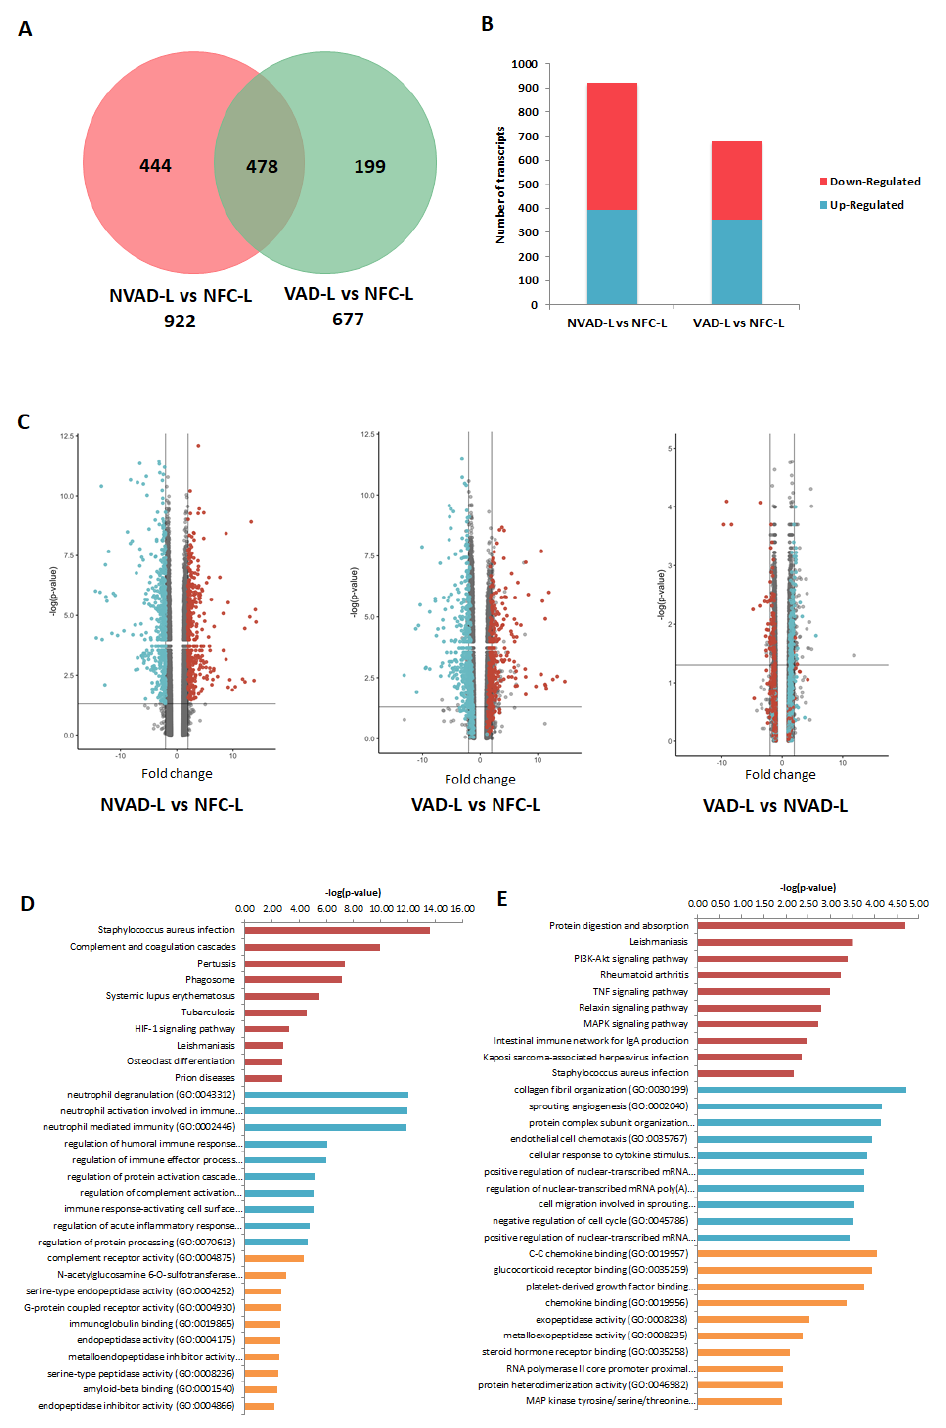
Figure 3. mRNA analysis of left ventricles (LV) from dilated cardiomyopathy (DCM) hearts with (VAD) and without left ventricle assist device (NVAD), using the non-failing controls (NFC) as reference. ( A ) Number of significant differentially expressed transcripts in the VAD and NVAD groups. ( B ) Number of significantly up- and down-regulated transcripts in the VAD and NVAD groups. ( C ) Volcano plots of microarray data from the VAD and NVAD groups. The LV DCM signature genes are marked (red: up-regulated, blue: down-regulated in NVAD group); grey vertical lines indicate two-fold fold-change values in either direction. Gene ontology (GO) analysis for ( D ) normalized genes in the LV following LVAD use and ( E ) additional differentially expressed LV genes following LVAD use. The top ten Kyoto Encyclopedia of Genes and Genomes (KEGG)